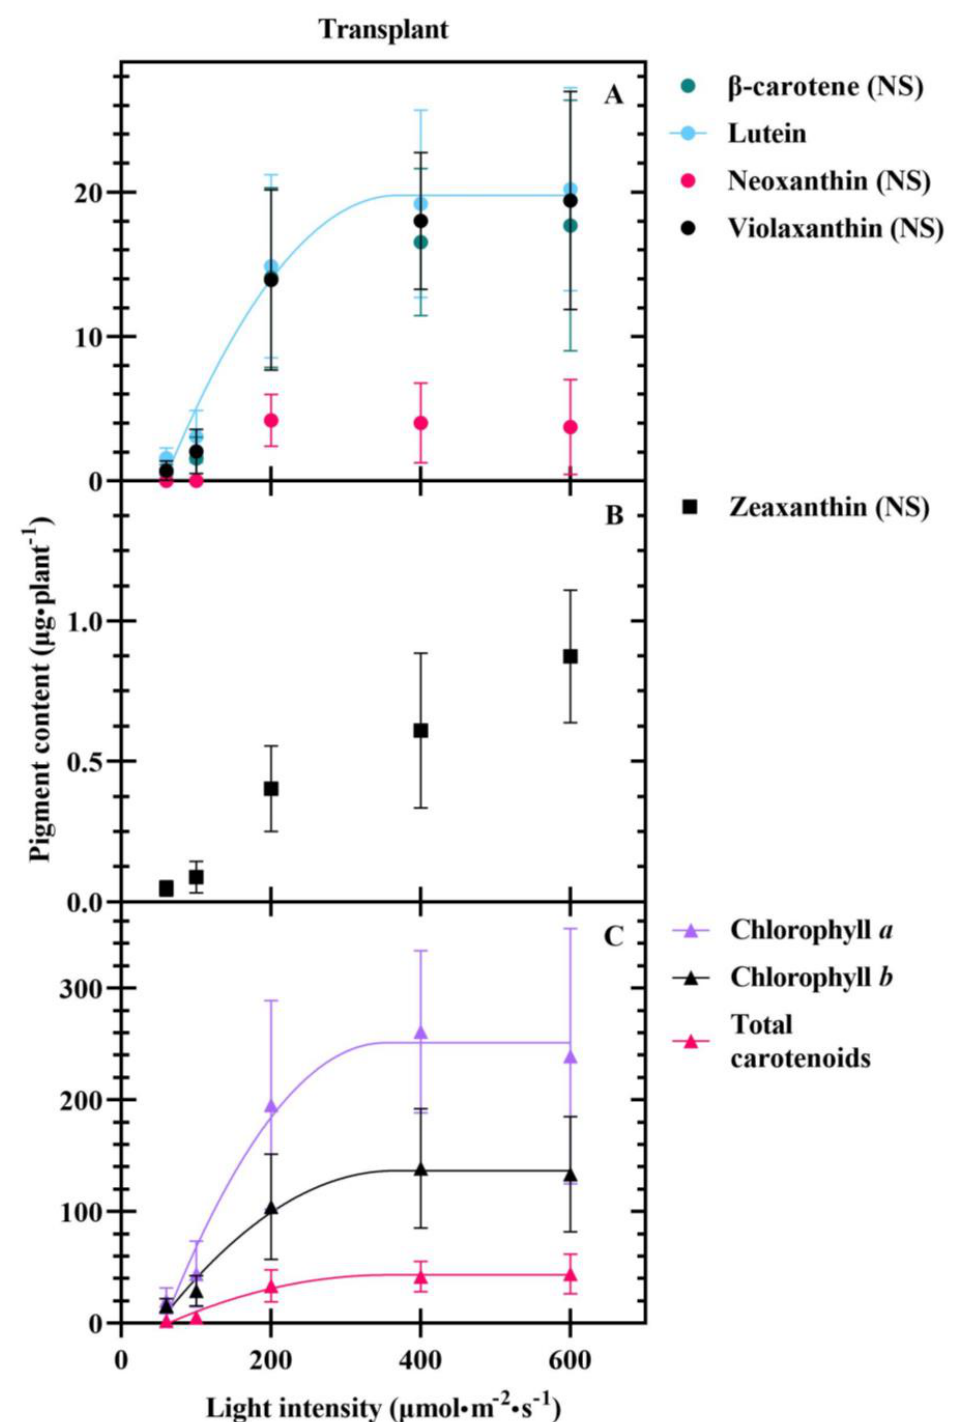
Figure 3. Content (µg·plant − 1 ) of β -carotene, lutein, neoxanthin, and violaxanthin ( A ), zeaxanthin ( B ), chlorophyll a and b , and total carotenoids ( C ) of 14-day old butterhead lettuce ‘Rex’ ( Lactuca sativa ) seedlings grown under light intensities of 60, 100, 200, 400, or 600 µmol·m − 2 ·s − 1 for a 24-h photoperiod. Each symbol represents the mean of 12 plants ± SE. Lines represent linear, quadratic, or quadratic plateau regression. Equations and significance are reported in Table 3. Table 3. Regression analysis parameters and R 2 for butterhead lettuce ‘Rex’ ( Lactuca sativa ) growth, development, and carotenoid and chlorophyll concentrations and content at transplant in response to seedlings grown under light intensities of 60, 100, 200, 400, or 600 µmol·m − 2 ·s − 1 for a 24-h photo- period for 14 d. 𝑥 = photosynthetic photon flux density ( PPFD ; µmol·m − 2 ·s − 1 ). X 0 = light saturation